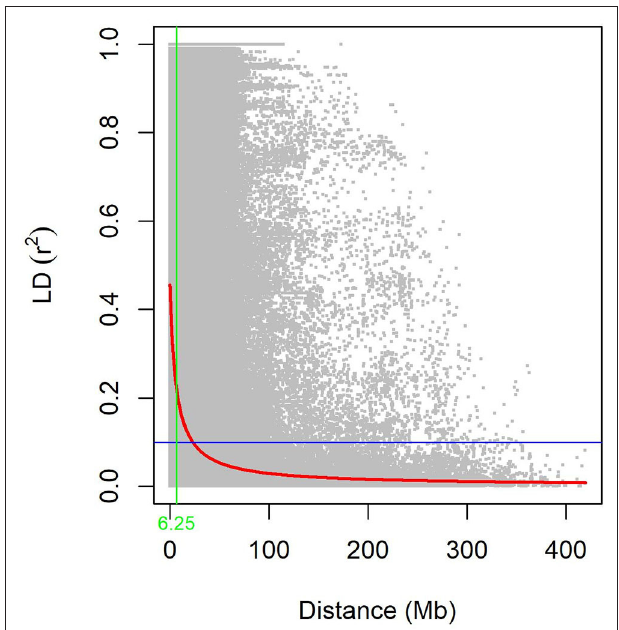
FIGURE 4 | The decay of linkage disequilibrium (LD) in the whole population (WP). Pairwise LD (r 2 ) values plotted vs . corresponding pairwise physical distance (Mb) of GBS-SNPs. The trend line of non-linear regressions against physical distance is given by the red line. The horizontal and vertical lines represent the critical value of r 2 (0.1) and LD decay values, respectively.